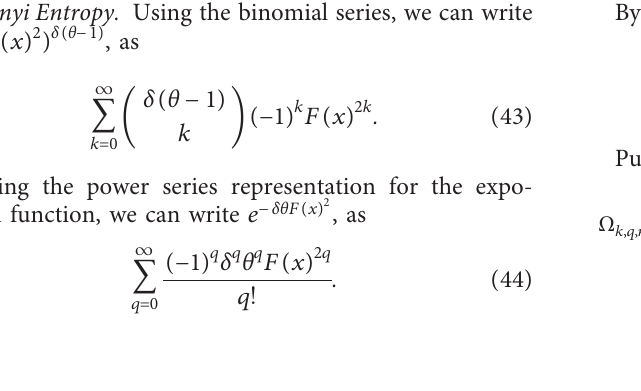
Figure 8: Biases and absolute biases plots of the NGE-Weibull distribution for α � 1 . 5, θ � 1 . 2, and c � 0 . 8.